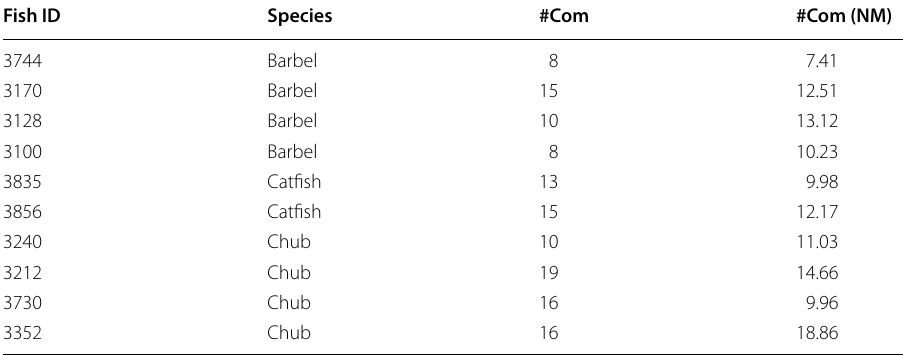
The metric based on the null model (NM) have been averaged over 100 replications. The associated standard deviations are available in Supplementary Information